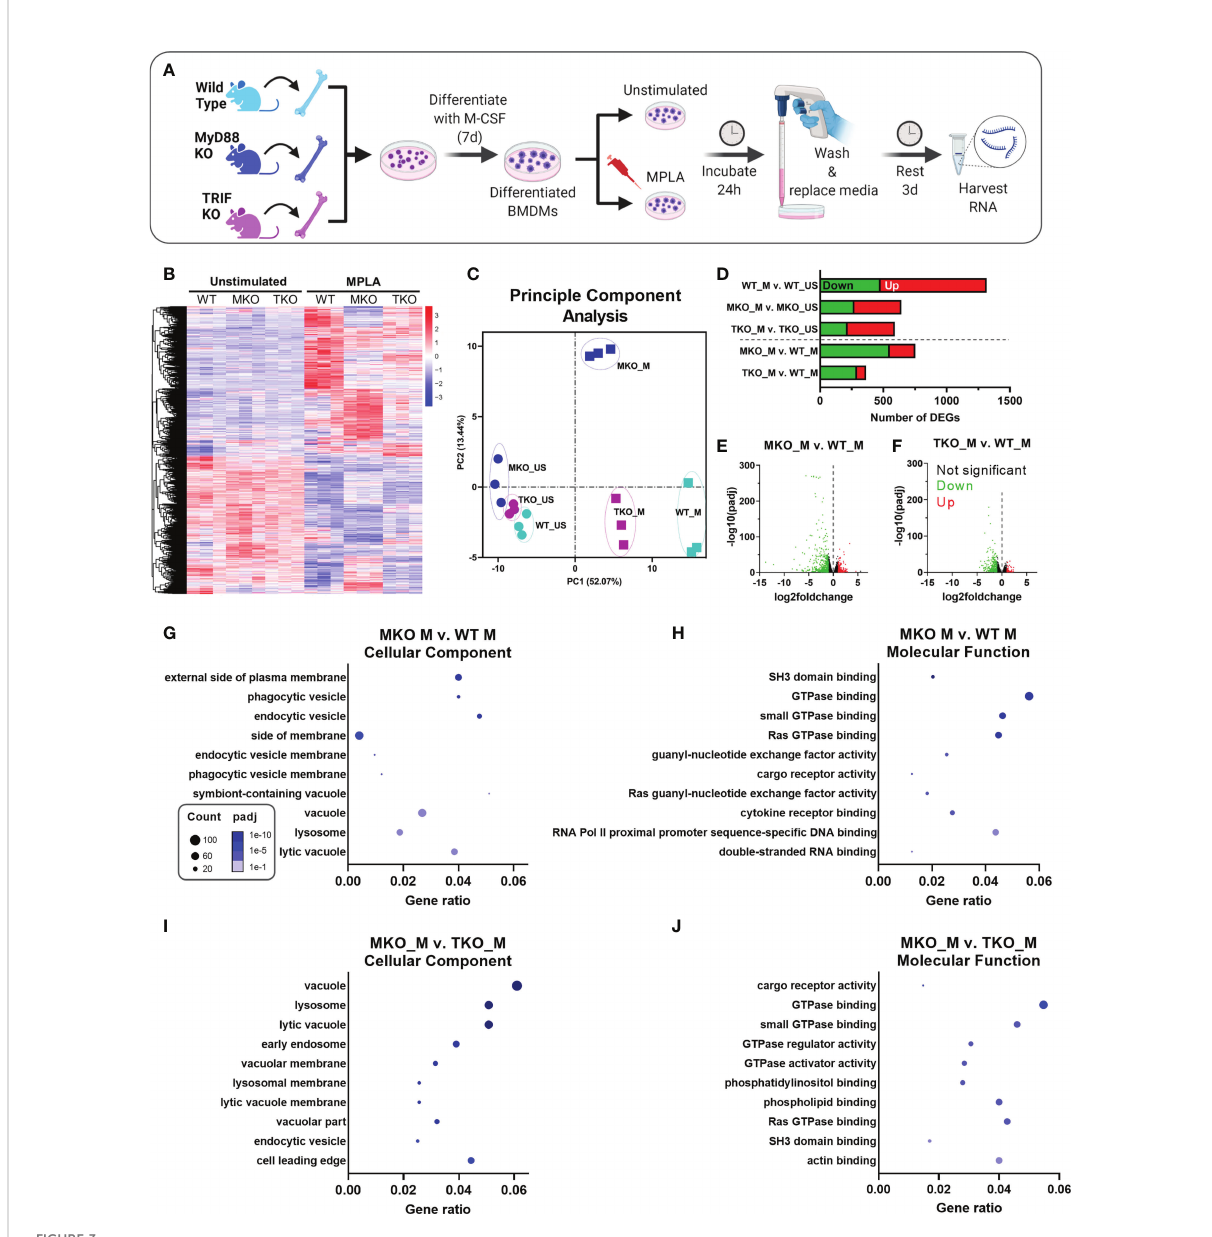
FIGURE 3 MPLA-induced transcription is blunted in TRIF-KO and MyD88-KO macrophages. (A) Bone marrow-derived macrophages (BMDMs) were cultured from WT, MyD88-KO (MKO) and TRIF-KO (TKO) mice. BMDMs were treated with MPLA (1 m g/mL) or left unstimulated (US) as controls. After 24h incubation, media was changed and cells were rested for 3 days before harvesting RNA for RNAseq analysis. (B) Differential gene expression analysis of unstimulated control or MPLA-treated WT, MKO, and TKO BMDMs as shown by heatmap of all samples represented by columns (n=3/group) and rows corresponding to different genes. (C) Principal component analysis of MPLA-treated (_M) or unstimulated (_US) WT, MKO, and TKO BMDMs was conducted. (D) The number of MPLA-induced differentially expressed genes (DEGs) compared to genotype unstimulated controls (above dotted line) or compared to MPLA-treated WT cells (below dotted line) were quanti fi ed. (E, F) Down-regulated (green) and up-regulated (red) DEGs were visualized by volcano plots for MPLA-treated MKO cells (E) or MPLA-treated TKO cells (F) compared to MPLA-treated WT cells. (G-J) Gene ontology (GO) functional enrichment analysis was conducted for the 10 most downregulated pathways in the cellular component and molecular function classes in MPLA-treated MKO compared to MPLA-treated WT macrophages (G, H) , or compared to MPLA-treated TKO macrophages (I, J) . The number of genes differentially regulated in each respective pathway (i.e. “ count ” ) are indicated by dot size and degree of signi fi cance (padj) by intensity of color. n=3 biological replicates/group. Log2foldchange >1 and adjusted p value < 0.05 were considered differentially